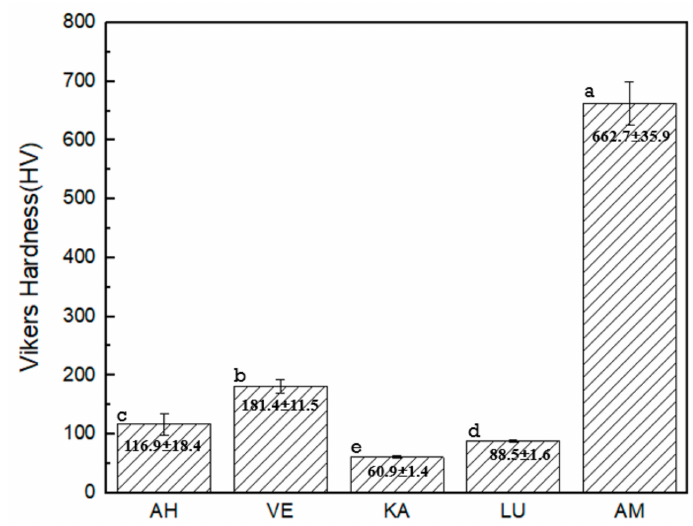
Figure 4. Mean values of Vickers hardness. * Di ff erent letters indicate statistically significant di ff erences ( p < 0.5).